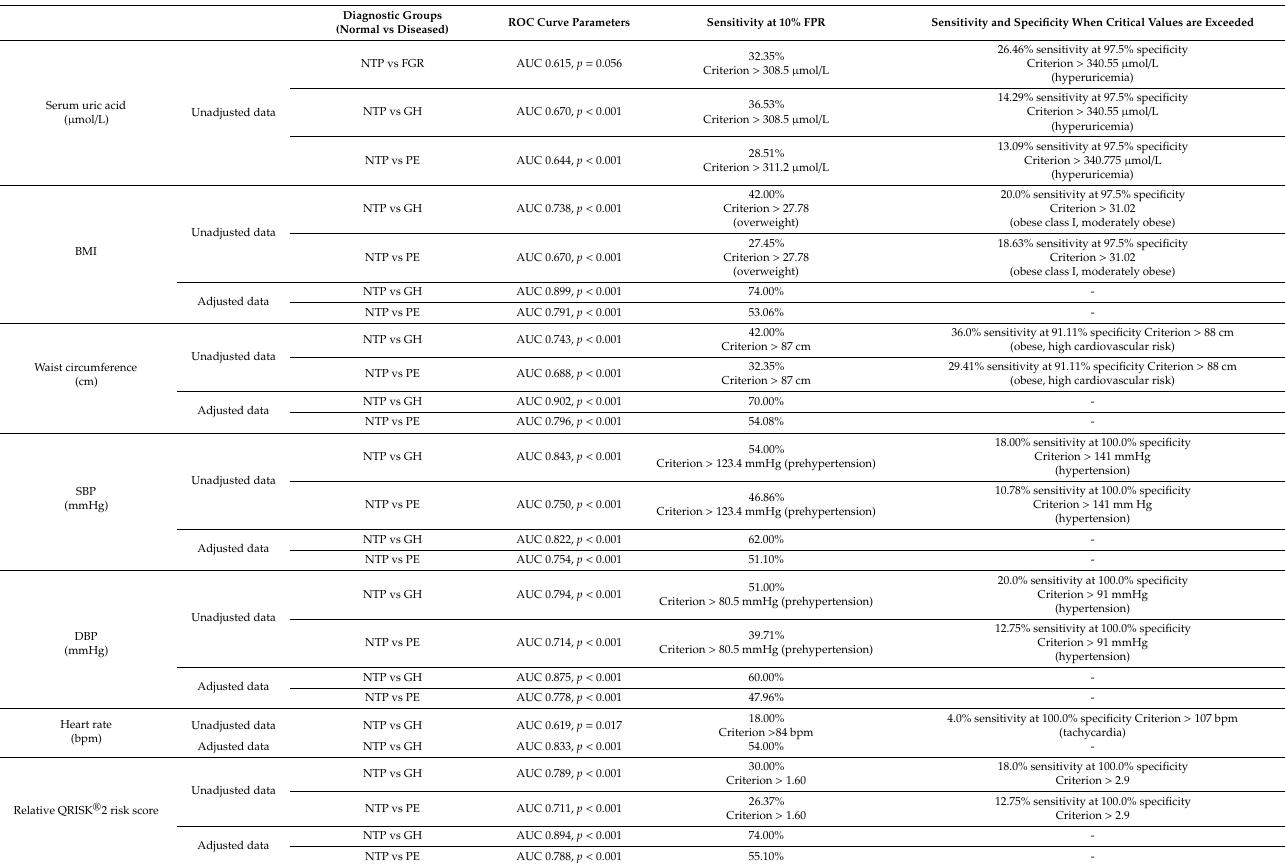
Table 3. Impact of GH or PE history on maternal cardiovascular risk - overview (Receive operating characteristics (ROC) curve analysis).